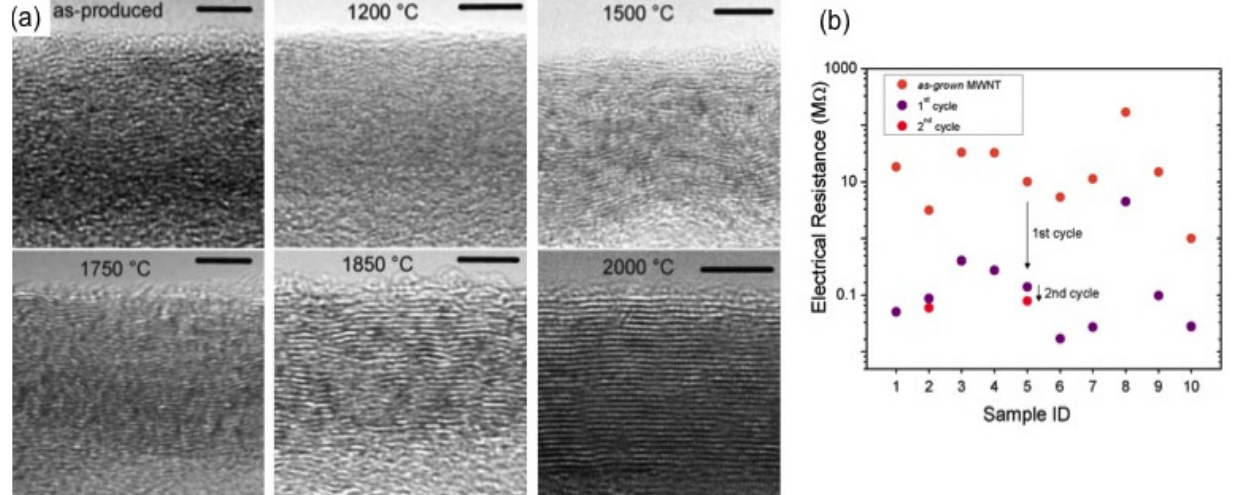
Figure 8. ( a ) Transmission electron micrographs of the walls of as-produced nanotubes grown in alumina template and at different annealing temperatures (as labeled). The initial, disordered carbon structure is converted into a more and more perfect graphitic structure with an increasing annealing temperature. Scale bar is 5 nm; ( b ) Variation of the electrical resistance in individual alumina template grown carbon nanotubes as function of the number of electrical cycles.